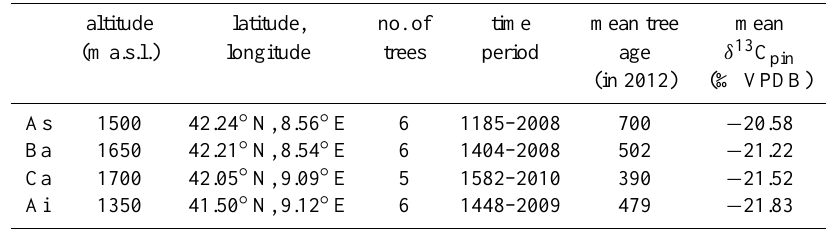
Table 1. Parameters of the study sites and carbon isotope chronologies. As: Asco, Ba: Ballone, Ca: Capannelle, Ai: Asinao, mean δ 13 C pin (‰ VPDB): mean value of carbon isotope chronology corrected with the pin correction (McCarroll et al., 2009) for the time period 1582– 2007AD.